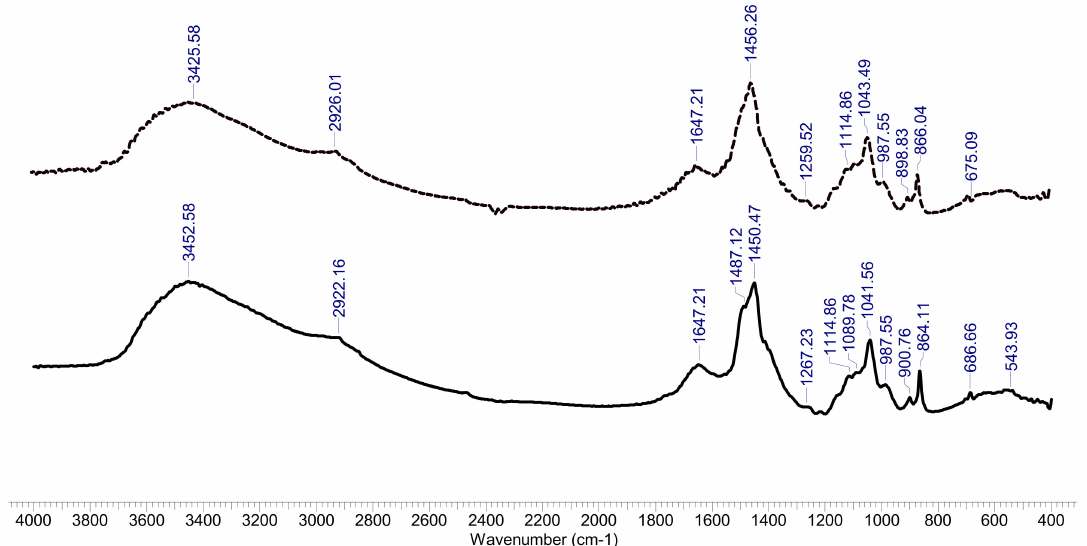
Figure 5. FTIR spectra of separated hemicelluloses. Black line, HCWS and dotted line,